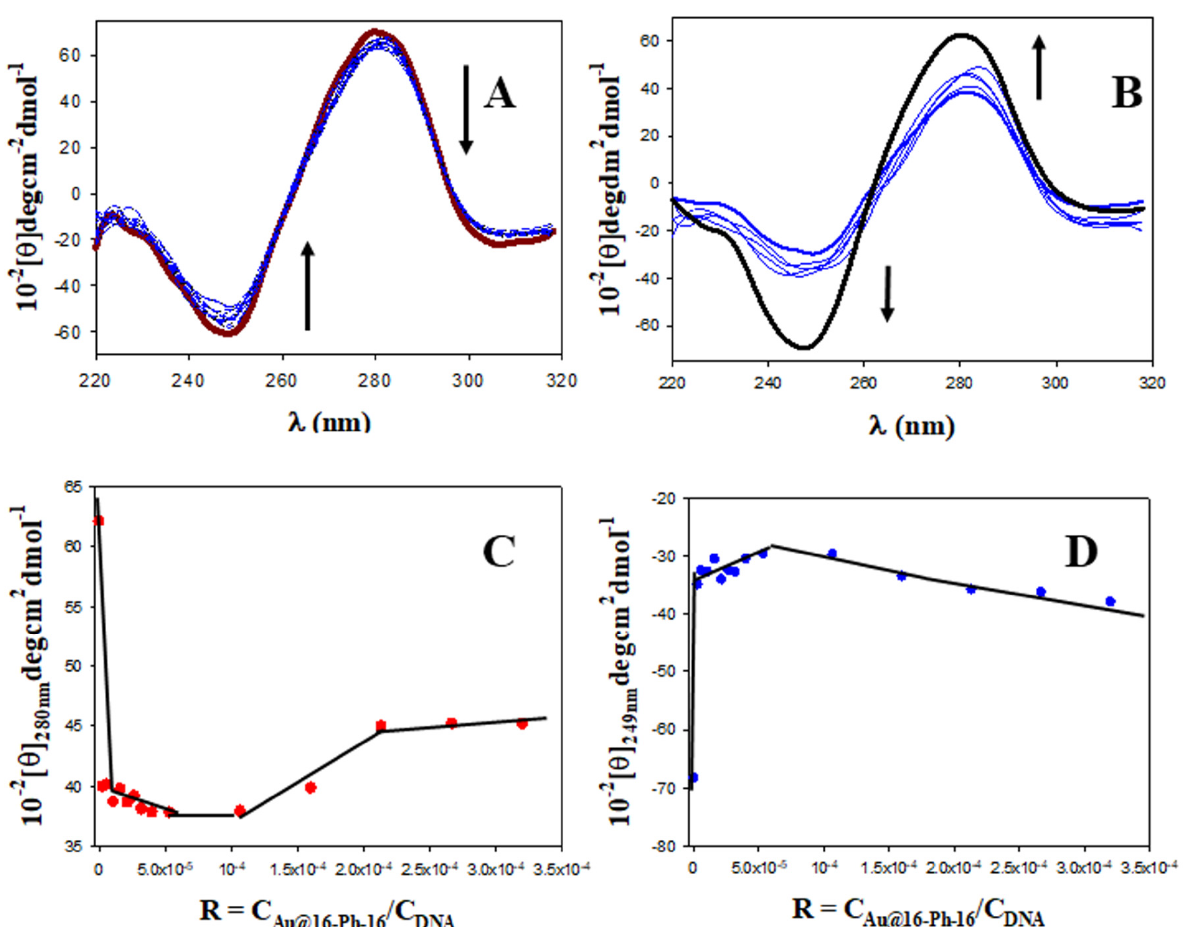
Figure 2. CD titrations of the DNA–Doxo system at different C Au@16-Ph-16 in cacodylate buffer (I = 1.63 mM, pH = 7.4); C Doxo = 5 µ M and C DNA = 200.0 µ M. CD spectra of free DNA and DNA/Doxo complex in black and red, respectively. ( A ) First behavior; the arrow indicates change at 0, 0.0053, 1.07, 2.13, 3.20, 4.27, 5.33, 6.40, 8.00, 10.7 and 21.3 nM of Au@16-Ph-16. ( B ) Second behavior; the arrow indicates change at 21.3, 32.0, 42.7, 53.3 and 64.0 nM of Au@16-Ph-16. ( C , D ) Plots of [ θ ] 280 nm and [ θ ] 249 nm versus